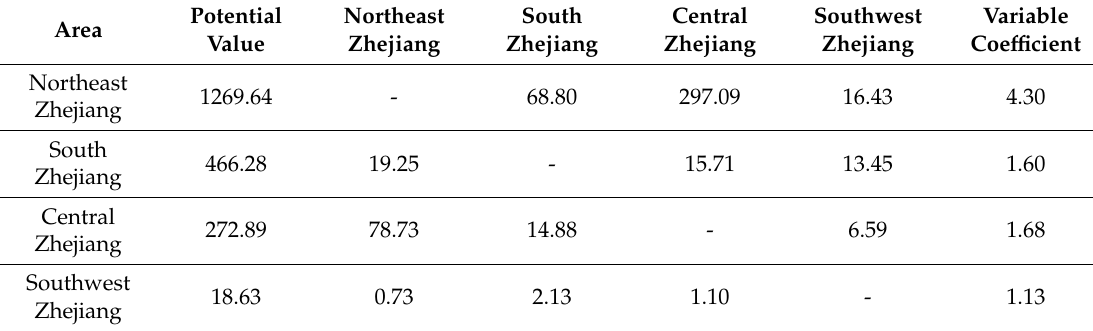
Table 2. E-retail economic contacts of regional di ff erence in Zhejiang